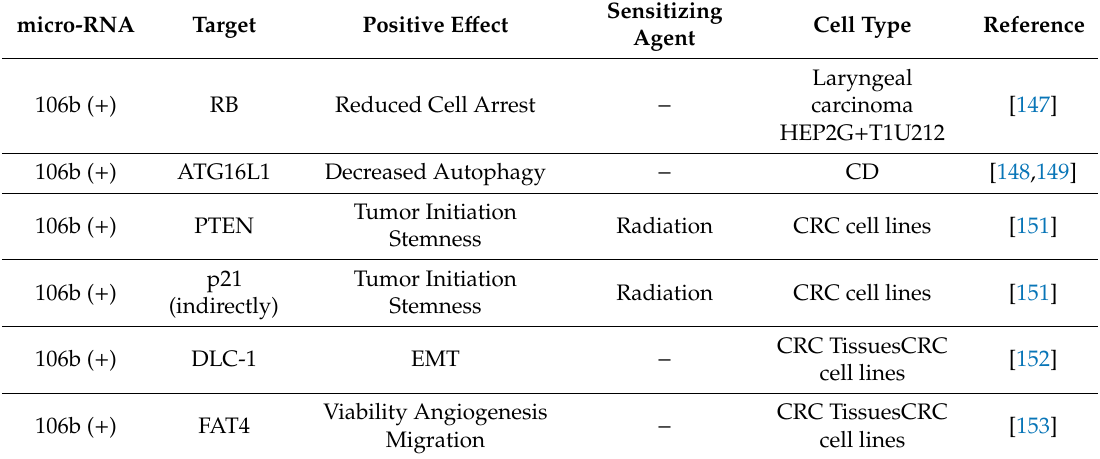
Table 7. Elevated ( + ) miRNA-106b levels are shown, as are their target genes, their biological e ff ects and whether these factors can sensitize cells to certain therapeutic agents. The cell types indicate the types of cells characterized. CD, Crohn’s Disease; CRC, colorectal